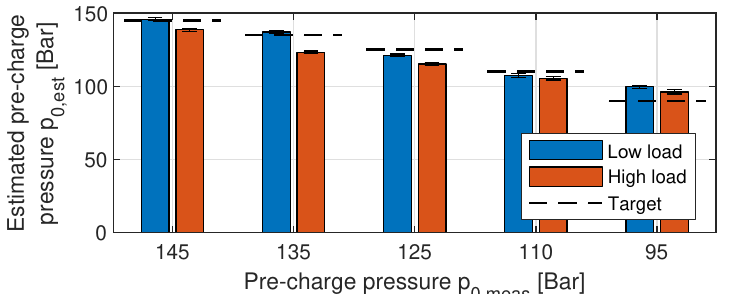
Figure 11. Estimated pre-charge pressures at selected levels for the low-load and high-load test sequences.